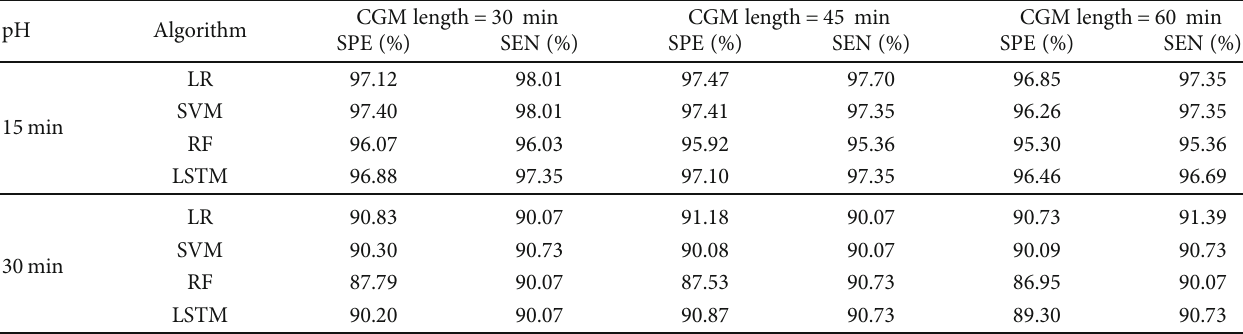
Table 2: The in fl uence of CGM length on the speci fi city and sensitivity of di ff erent algorithms when the metric of MSG+gradient was adopted. pH Algorithm